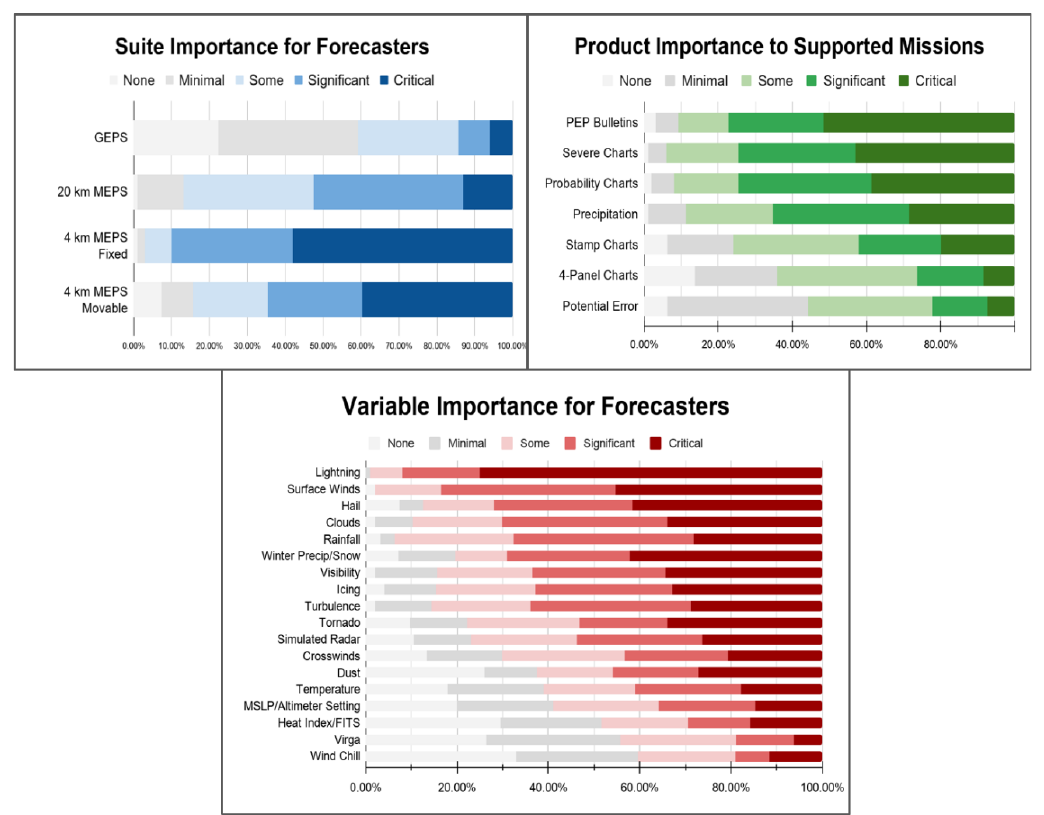
Figure 16. Ratings distribution for 100 survey responses received from August to October 2020 to the question “Please rate each of the following on how important it is to your efforts” where the “following” is each suite, product, and variable listed.